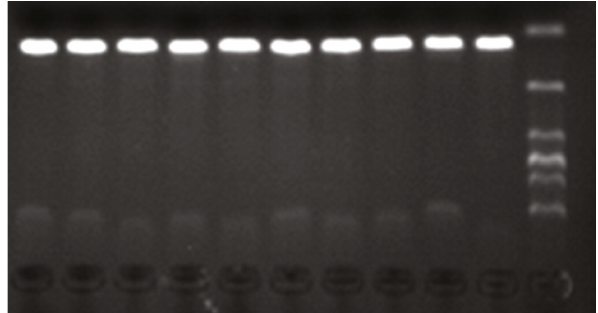
Figure 5: cDNA electrophoresis.